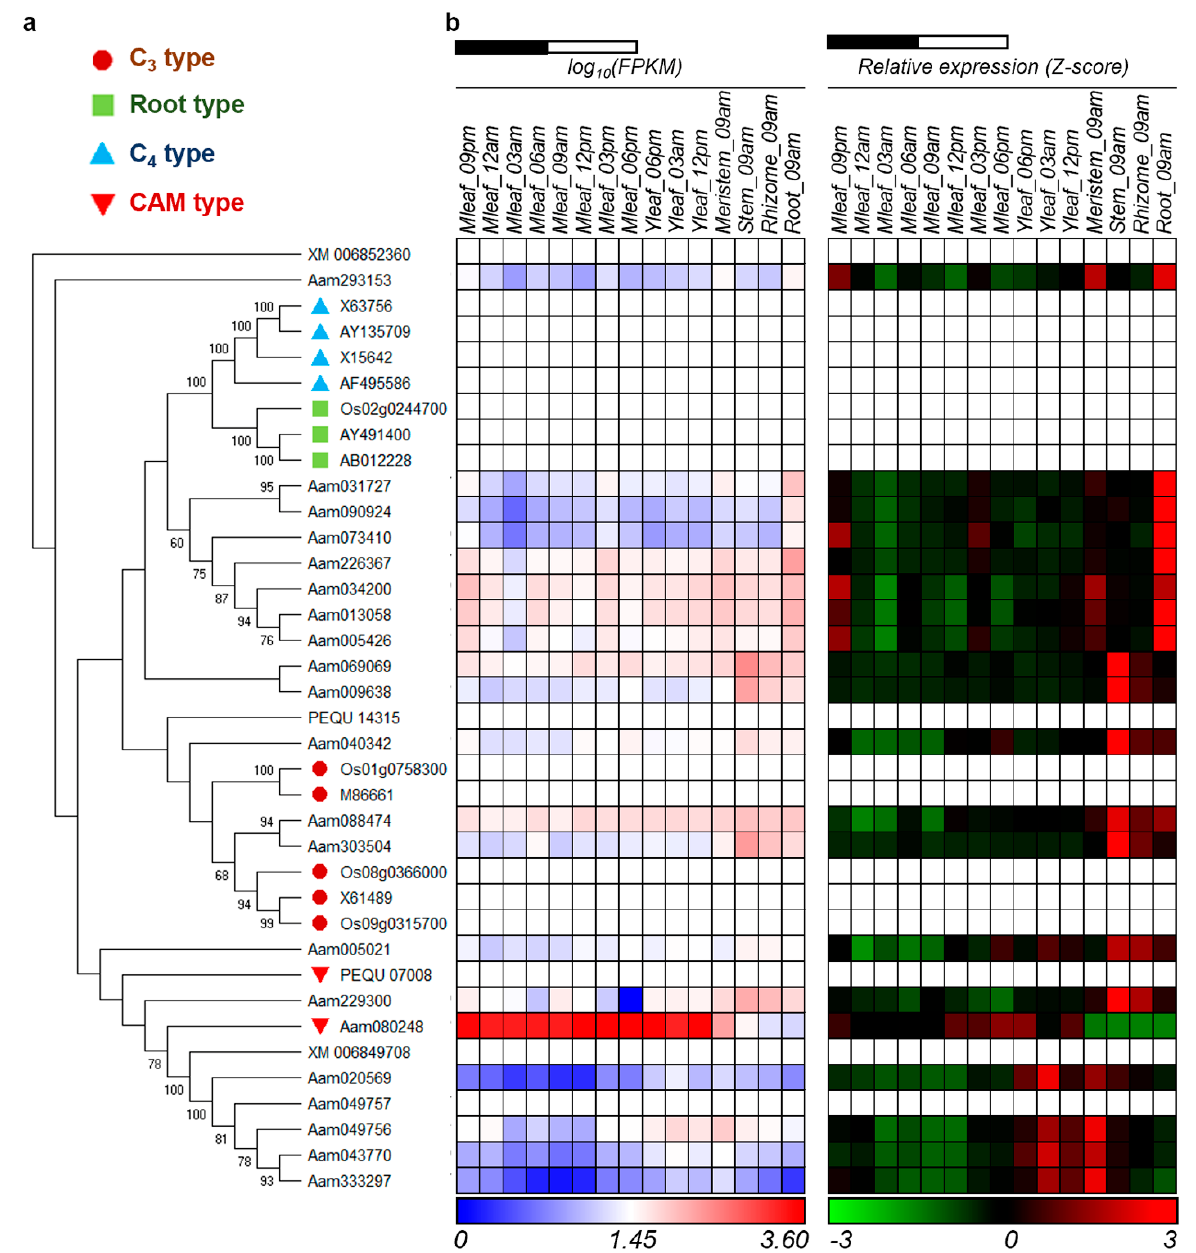
Figure 1. Identification of the crassulacean acid metabolism (CAM)-isoform of phospho enol pyruvate carboxylases (PEPC) in Agave americana. ( a ) Phylogenetic relationships of PEPCs in A. americana and plant-type PEPCs from other monocot plants. Bootstrap values are shown at nodes. The sources for the PEPC sequences (as well as species abbreviations, etc.) are provided in ‘Materials and Methods’. ( b ) Diel transcript expression of the PEPC genes in A. americana . The Z-score is defined as (x i − µ i )/ σ i , where x i is the FPKM of gene i, µ i is the mean and σ i is the standard deviation of all 15 columns. White and black bars indicate daytime (12 h) and nighttime (12 h), respectively. Mleaf: mature leaf; Yleaf: young